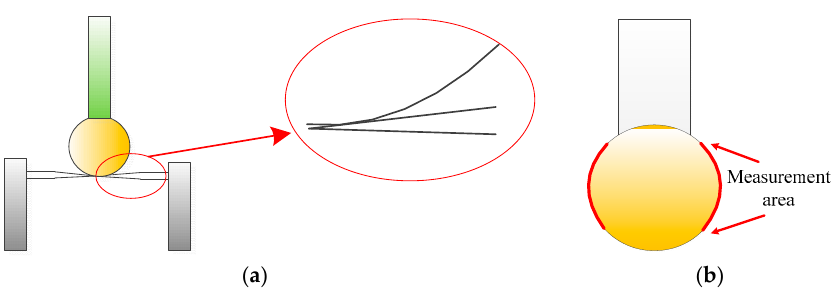
Figure 5. Principle of interference and measuring area. ( a ) Interference between the probe tip and sphere bottom area; ( b ) Measurement area.